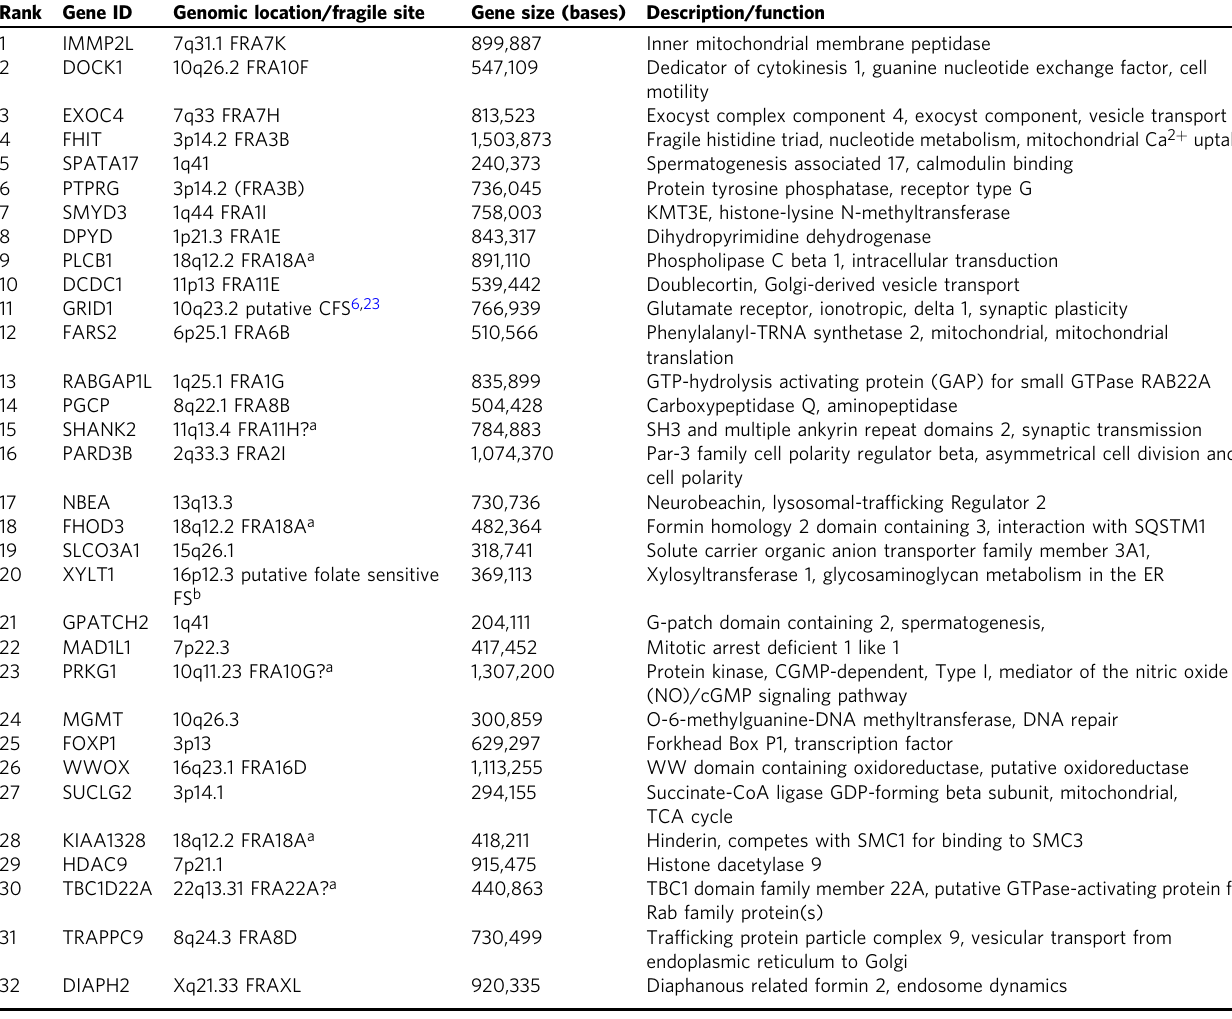
Table 1 Genes most enriched in FANCD2 after APH treatment. Rank Gene